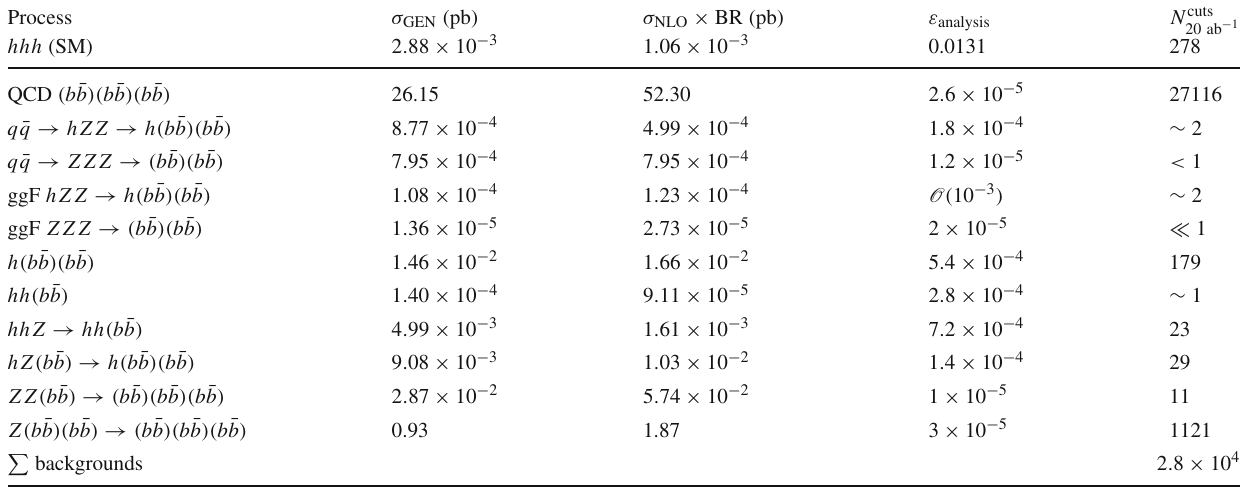
Table3 Theprocesses consideredinthesix b -jetanalysis,fortheStan- dard Model. The second column shows the generation-level cross sec- tions with the cuts (if any) as given in the main text. The Z bosons were decayed at generation level and hence the cross section is given with the Z branching ratios applied. The third column shows the starting cross section for the analysis, including the branching ratio to ( b ¯ b )( b ¯ b )( b ¯ b ) ,